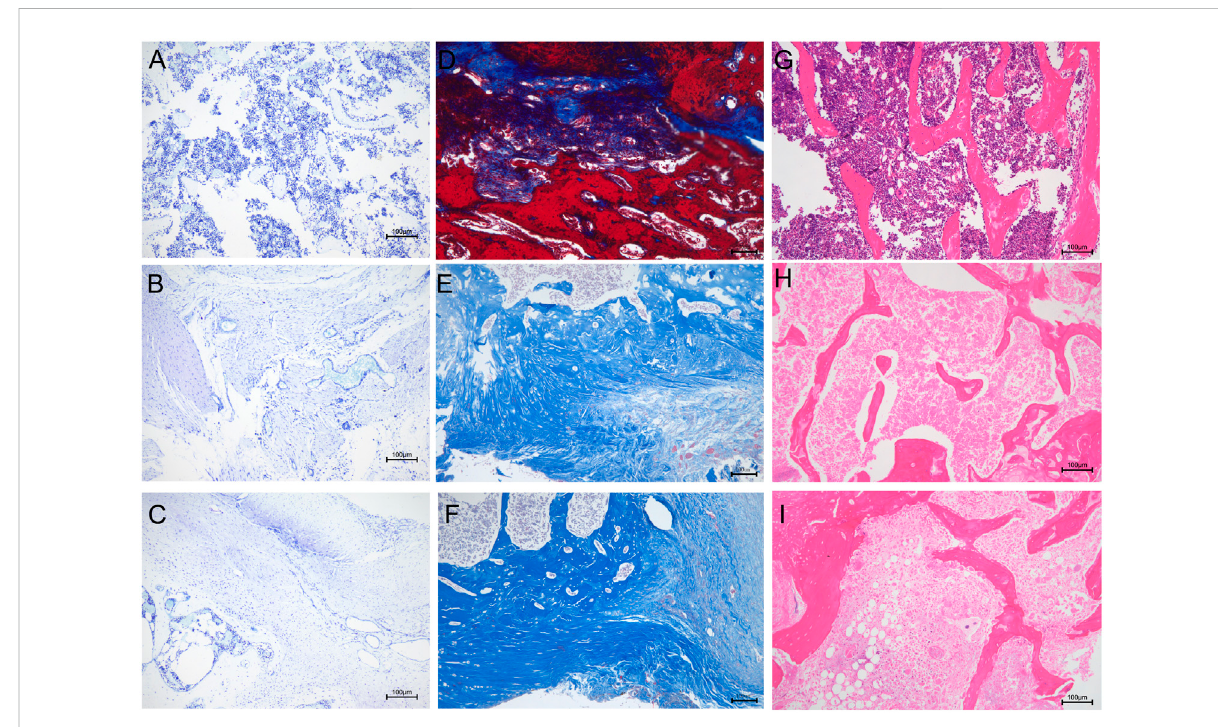
FIGURE 12 Histological analysis. Toluidine blue staining: (A – C) unmodi fi ed, (MMT/HA-RFP) 10 , and sham groups, respectively. Masson ’ s trichromestaining: (D – F) unmodi fi ed, (MMT/HA-RFP) 10 , and sham groups, respectively. H&E staining: (G – I) unmodi fi ed, (MMT/HA-RFP) 10 , and sham groups,